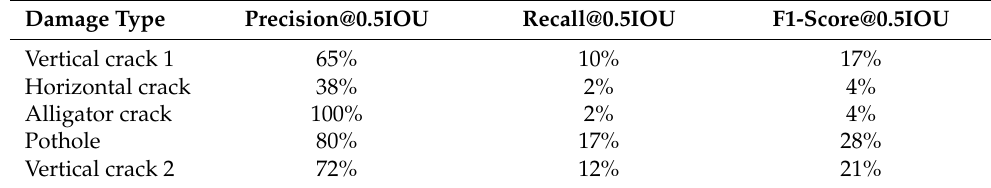
Table 14. Precision and recall for Model